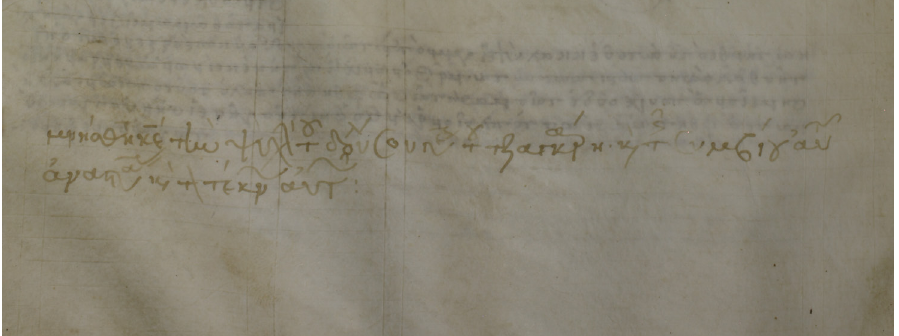
Figure 7. GA 2604 (CBL W 139) 310v (detail) The Center for the Study of New Testament Manuscripts (www.csntm.org)